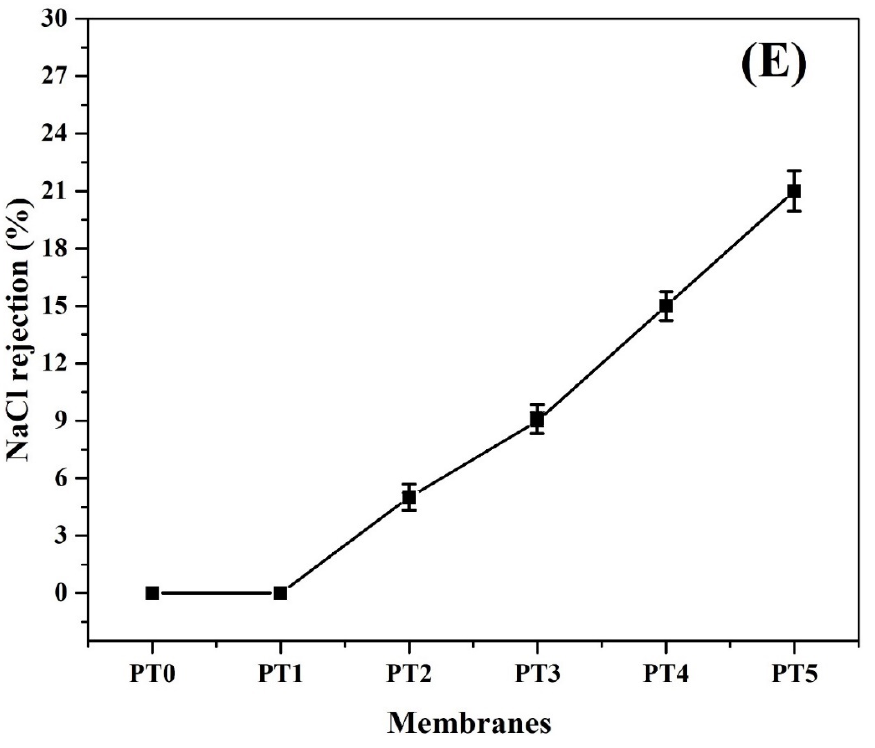
Figure 6. ( A ) Average flux for modified and unmodified PVDF membranes at different TiO 2 loading (0 to 5 wt.%) at an operating pressure of 3 bar for pure water and the dye solutions (RB and MO) (Dye concentration = 50 mg/L); ( B ) Rejection of dyes by TiO 2 /PVA modified and unmodified PVDF membrane during filtration (Dye concentration = 50 mg/L and experimental duration = 60 min);( C ) Effect of solution pH on photodegradation of dyes (MO and RB) at 50 mg/L of dye concentrations under UV irradiation (Time =180 min); ( D ) Effect of NaCl concentration on RB (50 mg/L) treatment (P = 0.3 MPa); ( E ) NaCl rejection at different TiO 2 loading.